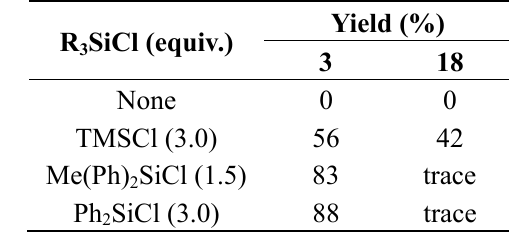
Table 1. Reaction yields of C